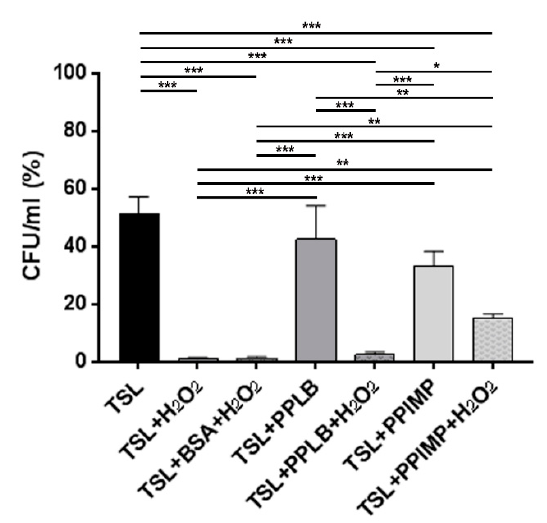
Figure 6. The survival rates of AB5075 cells incubated with periplasmic fractions extracted from A. baumannii cultures grown in the presence and absence of IMP and challenged with 2 mM of H 2 O 2 . Bacterial starting viability was controlled by re-suspending the inoculum used in this assay (1 × 10 6 / mL) in sodium chloride 0.9% (NaCl) which was set as 100% (not shown). Due to its composition, the periplasmic extraction bu ff er TSL (30 mM Tris-HCl–20% sucrose (pH 8.1), lysozyme 100 mg / mL in 0.1 M EDTA [pH 7.3]) was used as the control. The untreated and H 2 O 2- treated bacteria resuspended in the periplasmic extraction bu ff er TSL in the presence of periplasmic extracts extracted from cells grown in LB (PPLB) or in LB supplemented with IMP (PPIMP). The untreated and H 2 O 2 -treated bacteria with or without the addition of 50 µ g / mL of bovine serum albumin (BSA) to bu ff er hydroxyl radicals served as controls. Asterisks represent p values evaluated by one-way ANOVA; *** p < 0.001, ** p < 0.01, * p < 0.05.